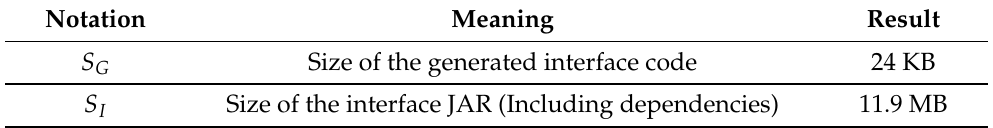
Table 6. Sizes of the generated